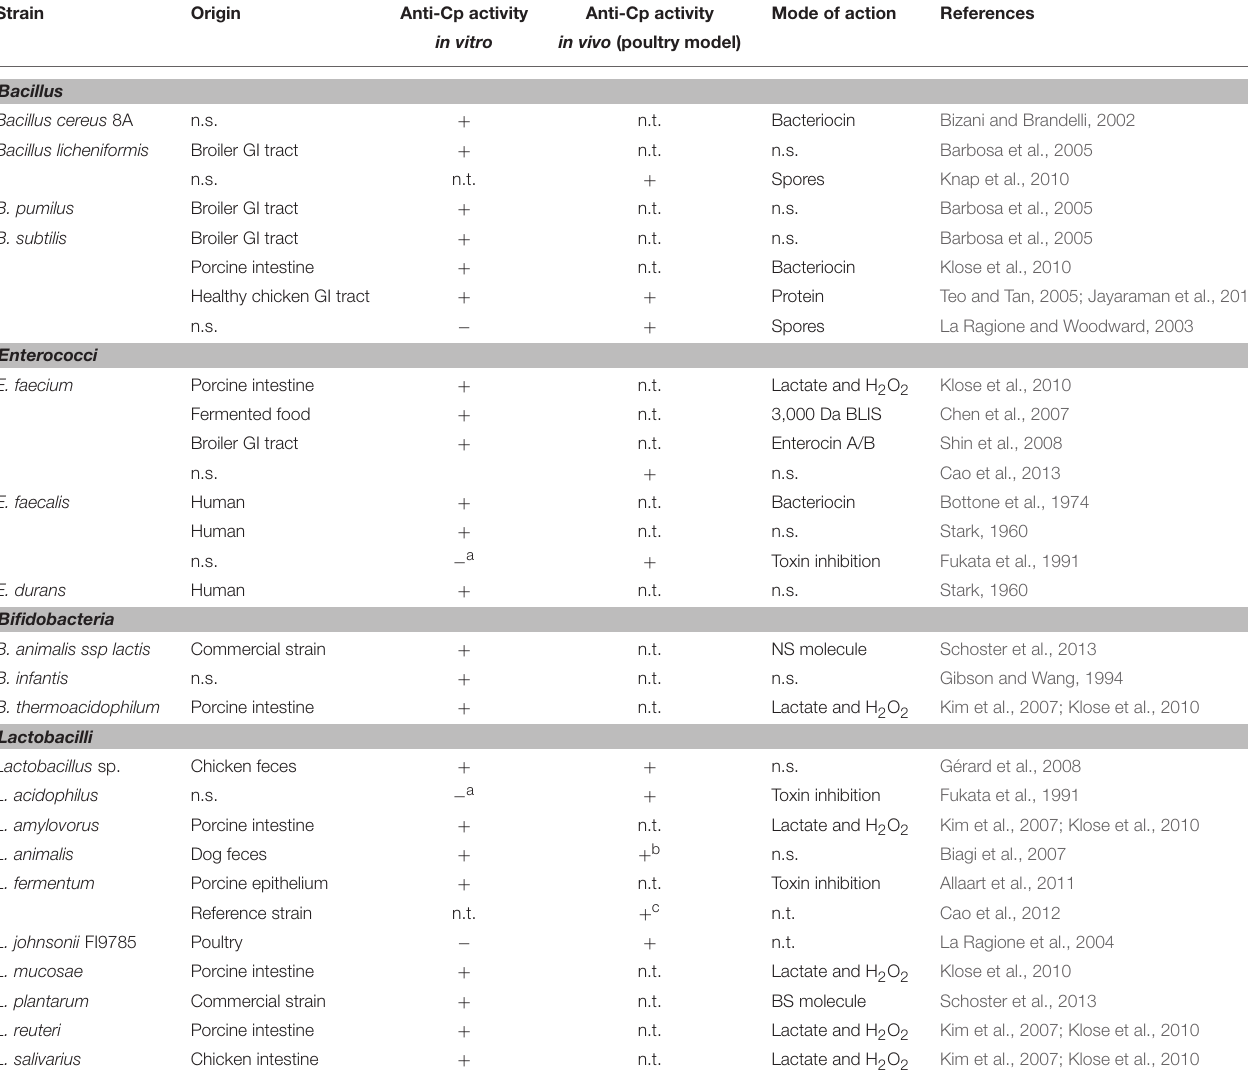
TABLE 2 | Examples of probiotic strains with anti- C. perfringens activity in vitro and in vivo .